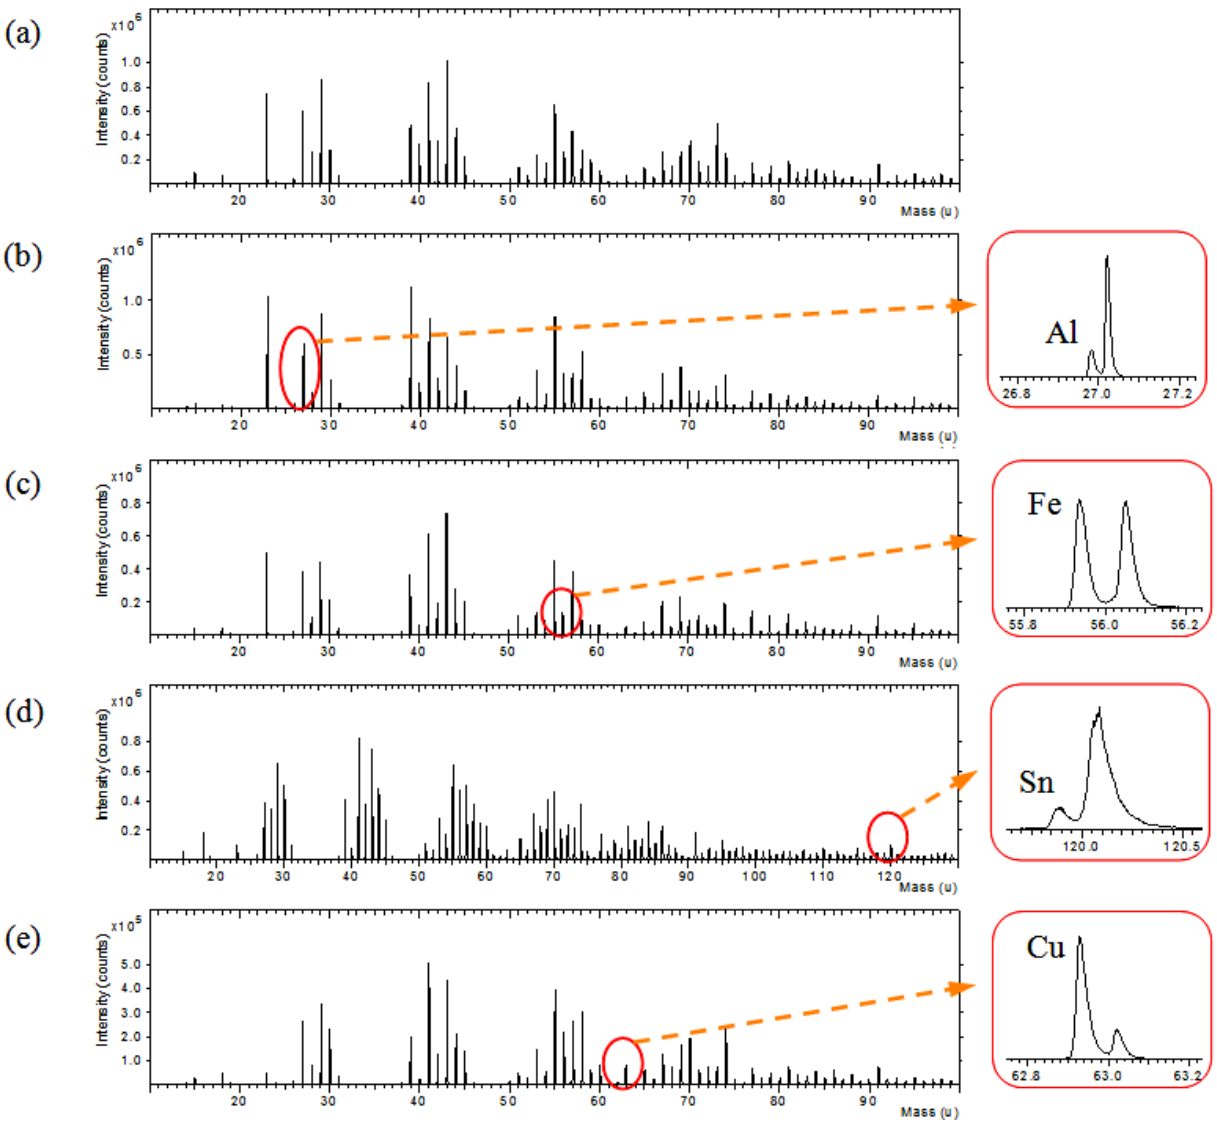
) ; ( c ) FeSO ; ( d ) SnCl ; and ( e ) CuSO 4 2 4 4 4